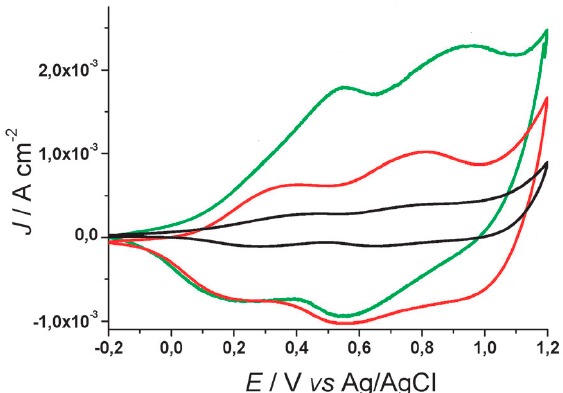
Figure 2. Cyclic voltammetries of mesoporous NiO cathodes at three different values of electrode thickness l . J and E represent the current density and the applied potential, respectively. Black trace: l = 0.4 μ m; red trace: l = 1.8 μ m; green trace: l = 2.7 μ m. NiO is the electroactive species which undergoes the solid state redox processes NiO x (OH) n (H 2 O) p → NiO x (OH) n +1 (H 2 O) p − 1 + e − + H + for the oxidation peak recorded at lower electrical potential, and NiO x (OH) n +1 (H 2 O) p − 1 → NiO x (OH) n +2 (H 2 O) p − 2 + e − + H + for the oxidation peak determined at higher electrical potential. Electrolyte: 0.2 M KCl, 0.01 M KH 2 PO 4 and 0.01 M K 2 HPO 4 in distilled water. Scan rate: 40 mV ∙ s − 1 . Adapted from reference [10].